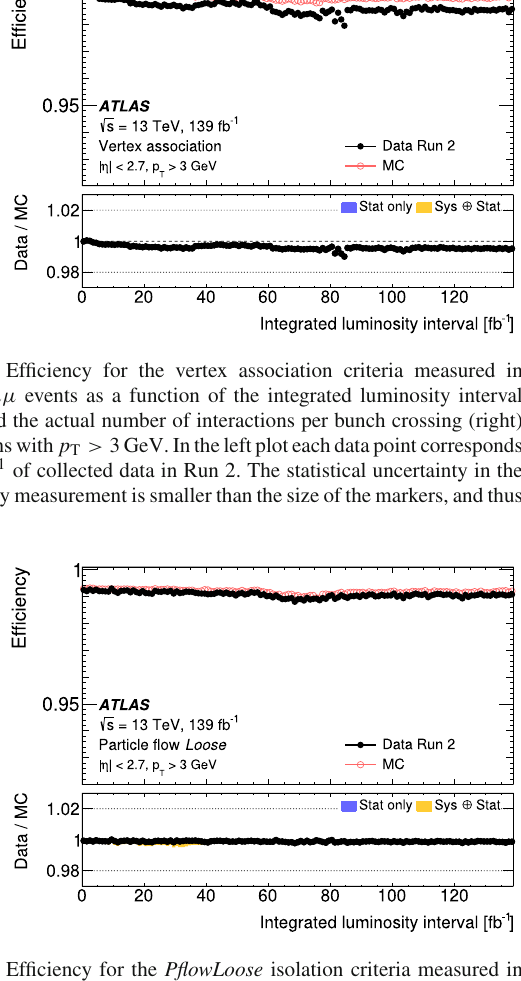
to 1 fb − 1 of collected data in Run 2. The statistical uncertainty in the efficiency measurement is smaller than the size of the markers, and thus not displayed. The panel at the bottom shows the ratio of the measured to predicted efficiencies, with statistical and systematic